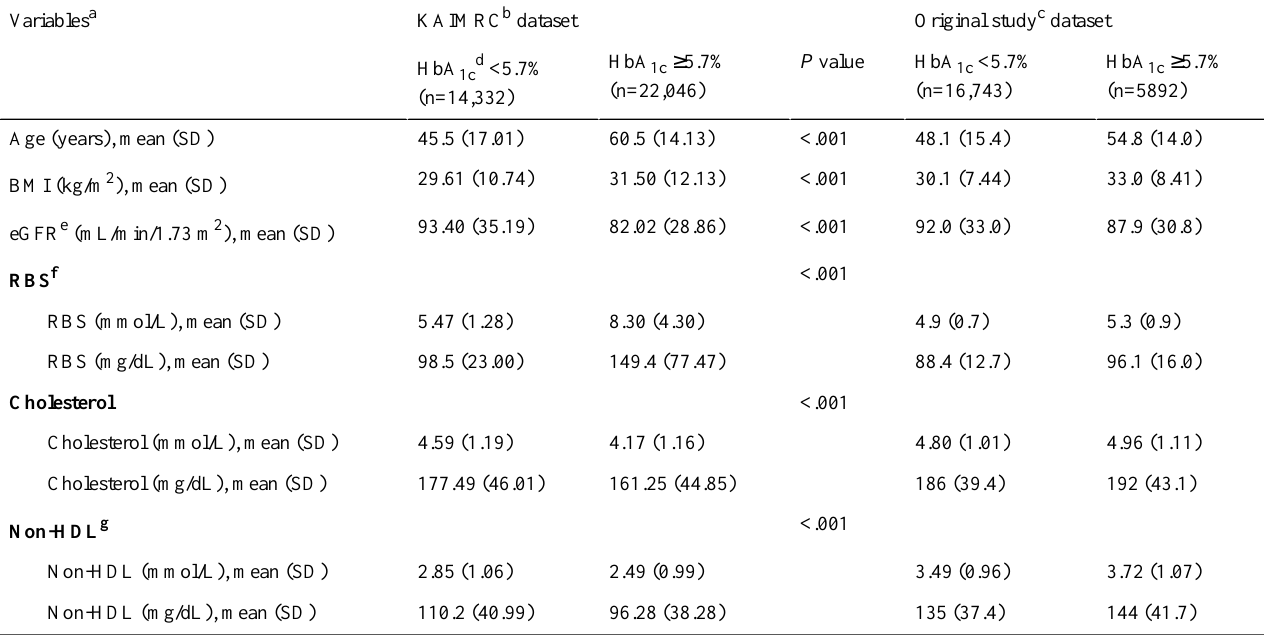
Table 2. Descriptive statistics for King Abdullah International Medical Research Center and original study